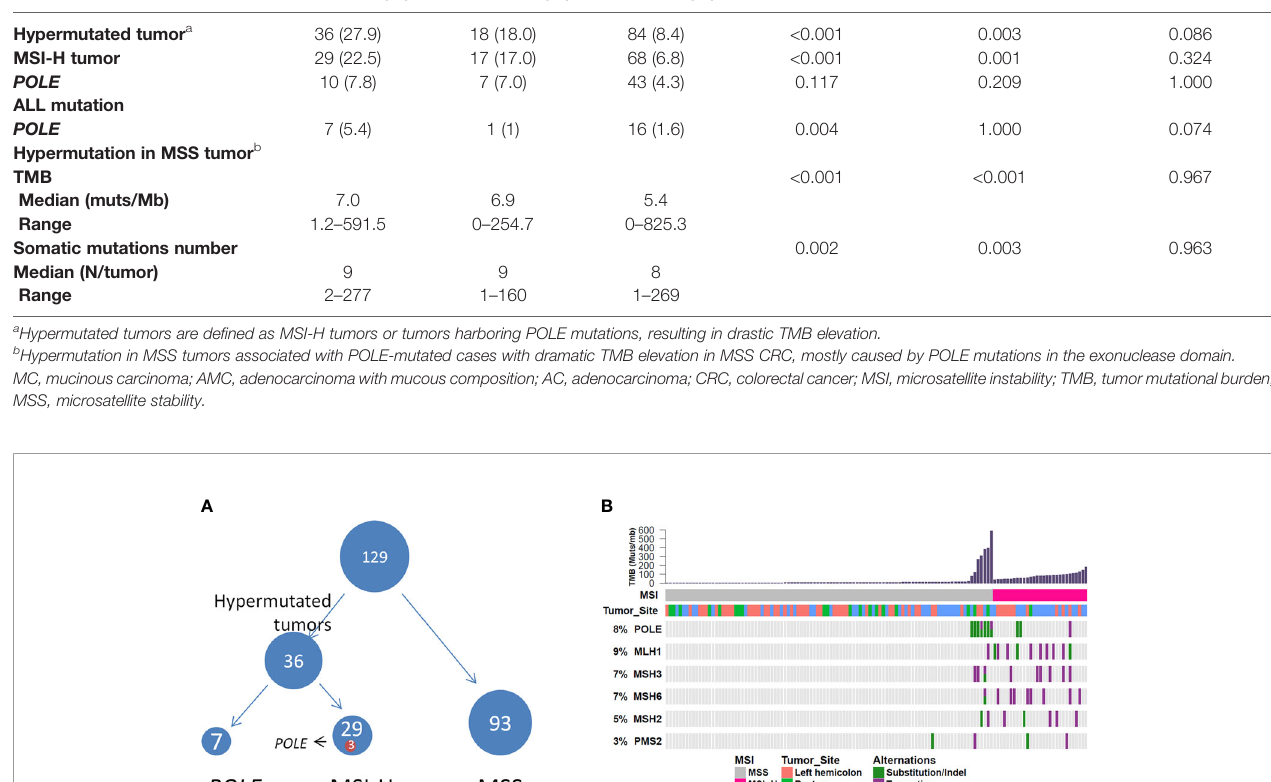
TABLE 3 | Comparison of immunotherapy-related biomarkers in MC, AMC, and AC. Characteristics